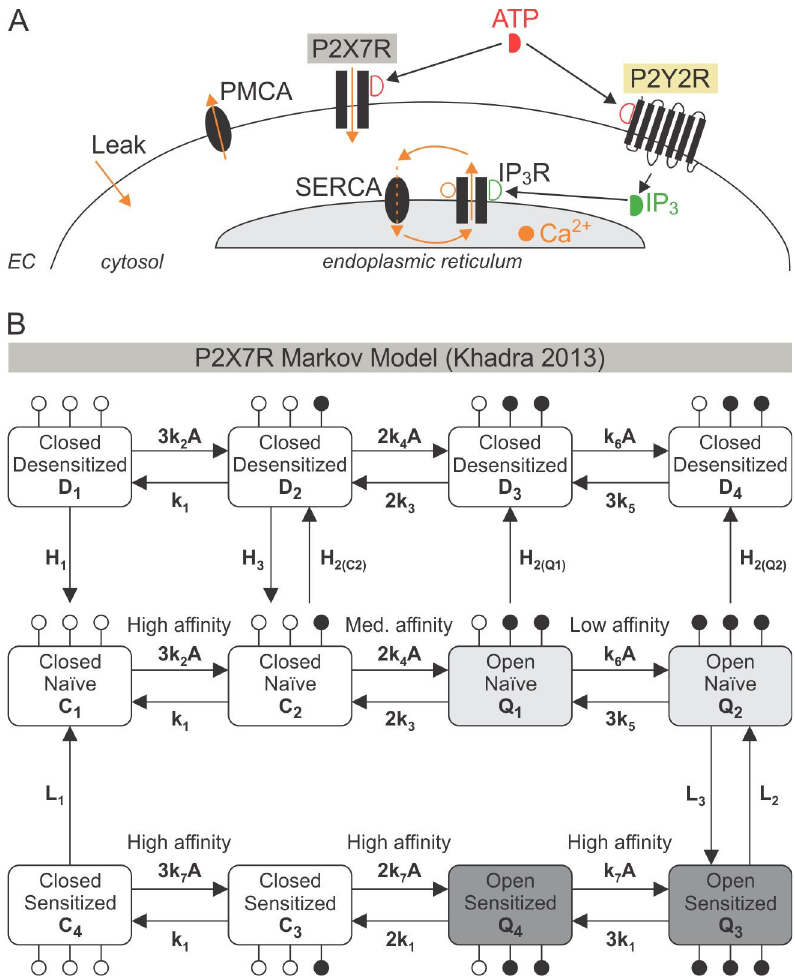
Fig 3. Schematic of the mathematical model describing P2 receptor-mediated Ca 2+ responses. (A) ATP activates P2X7 and P2Y2 receptors on the plasma membrane, stimulating Ca 2+ entry and IP 3 production, respectively. IP 3 production leads to Ca 2+ release from the endoplasmic reticulum (ER) through IP 3 Rs. Sarco/endoplasmic Ca 2+ ATPase (SERCA) activity replenishes the ER and allows for Ca 2+ oscillations when combined with the biphasic response of IP 3 Rs to Ca 2+ due to Ca 2+ -induced Ca 2+ -release (CICR). Ca 2+ is removed from the cell by plasma membrane Ca 2+ ATPases (PMCA). A constant inward Ca 2+ leak ensures positive [Ca 2+ ] i in the absence of ATP. EC : extracellular space. (B) Schematic of the P2X7R Markov Model. Middle , lower and upper rows : Fraction of P2X7Rs in na ï ve,sensitized and desensitized states, respectively. Open and solid circles : Sites unoccupied and occupied by ATP, respectively. Receptors in the closed ( C ) and desensitized ( D ) states have closed channel pores, whereas receptors in the open ( Q ) states, have i i i open channel pores with identical conductance, i = 1 − 4.Model parameter values are listed in Table 1 . ( Fig 3B ) [18]. The P2X7R submodel assumes that each receptor has three ATP binding sites, two of which must be occupied for the receptor to be open, and that each state represents the fraction of receptors with a given number of occupied ATP-binding sites ( Fig 3B , solid circles ). The closed, C , and desensitized, D , states are non-conducting, whereas the open states Q i i i ( i = 1 − 4) possess the same conductance g . The states were divided into three rows corre- X 7 sponding to desensitized ( Fig 3B , top row ), na ï ve ( Fig 3B , middle row ) and sensitized or primed ( Fig 3B , bottom row ) states, respectively. The na ï ve row is comprised of the states C , 1 C 2 , Q 1 , Q 2 that have not been exposed to ATP for a prolonged period of time, whereas the sen- sitized and desensitized rows are comprised of the states C , C , Q , Q ( D , D , D , D ) that 3 4 3 4 1 2 3 4